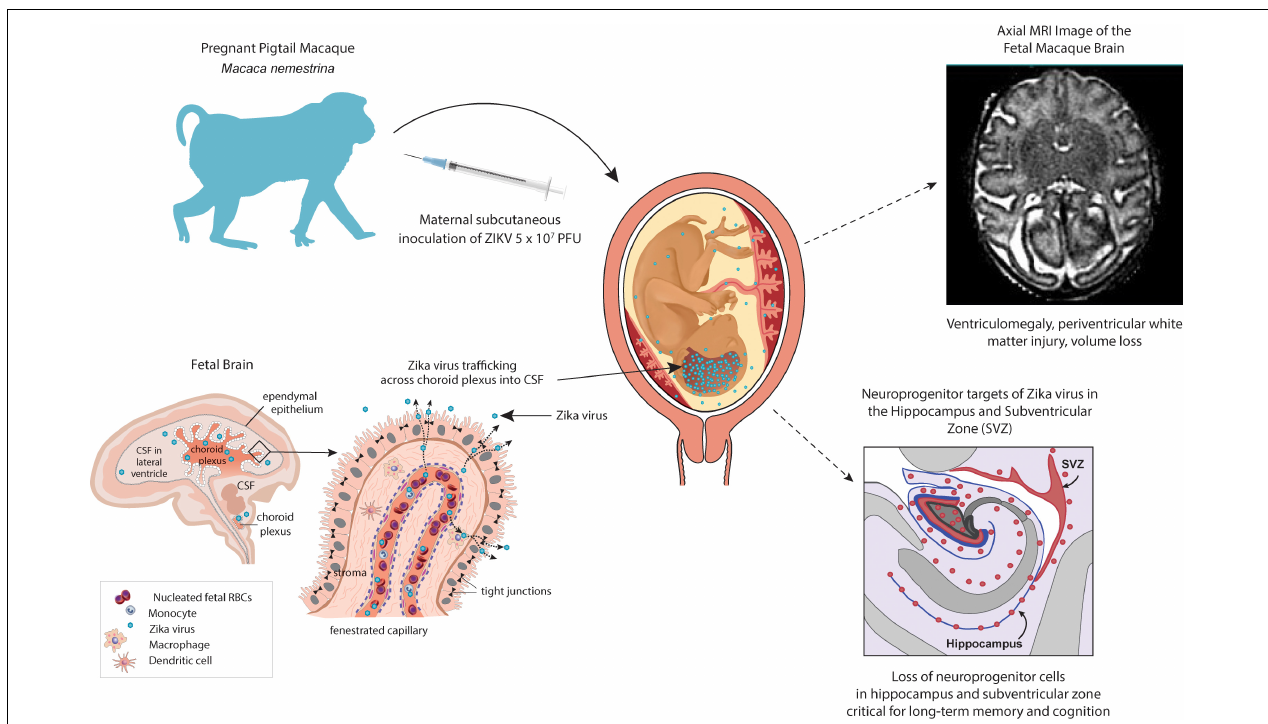
FIGURE 1 | NHP pigtail macaque ( M. nemestrina) model of the congenital Zika syndrome. A pregnant pigtail macaque is inoculated subcutaneously with 10 7 plaque-forming units to mimic a mosquito bite leading to maternal viremia and detectable viral RNA in the fetus and fetal brain. A fetal magnetic resonance imaging scan demonstrates a periventricular T2-enhancing lesion upper right , which correlates with white matter injury. Neuroprogenitor cells (Tbr2+) in the hippocampus and subventricular zone ( lower right , indicated by pink shading or pink dots) were significantly lower in ZIKV-exposed fetuses than in controls. In the lower left panel , an illustration of the choroid plexus demonstrates a hypothesized route for ZIKV entry into the fetal brain wherein the virus could directly enter the cerebrospinal fluid and subsequently, access all brain internal